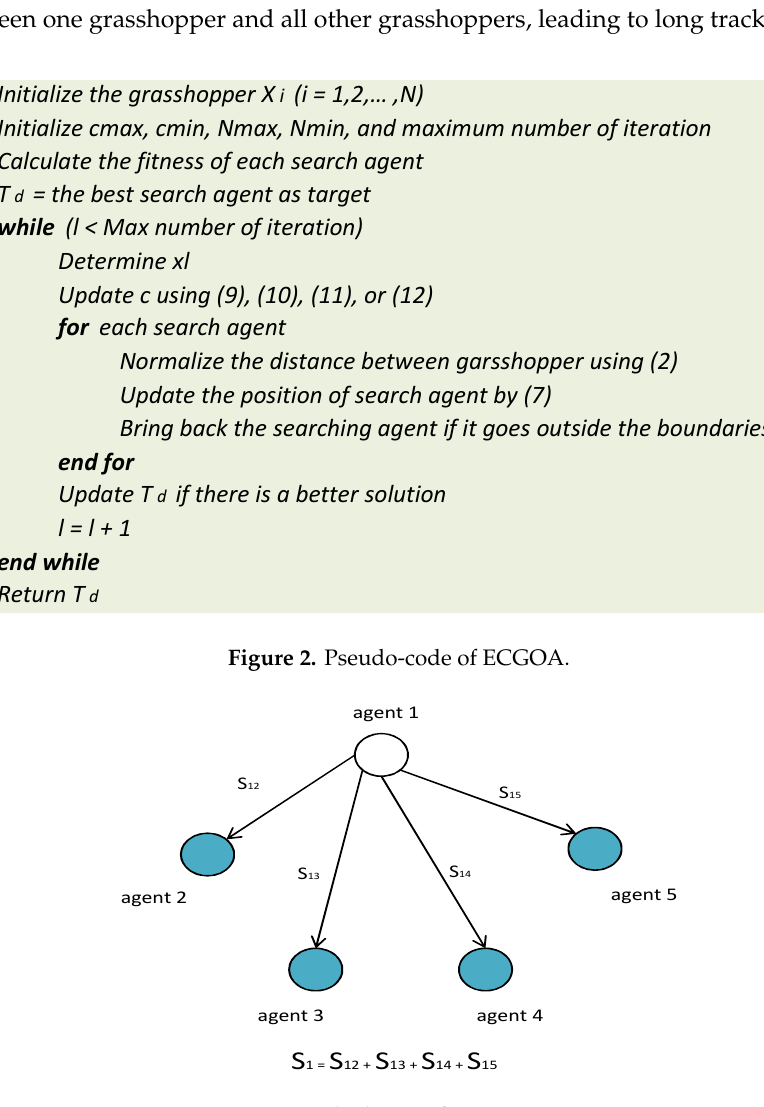
Figure 3. Calculation of